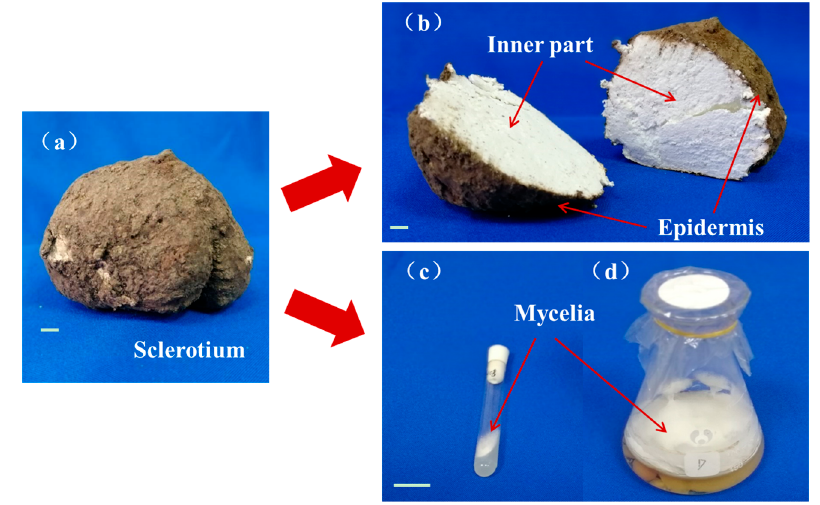
Figure 1. Whole sclerotium ( a ), cut sclerotium of Poria cocos ( b ), isolated P. cocos strain kept in a glass tube ( c ) and mycelia fermented in liquid medium ( d ); bar, 2 cm.